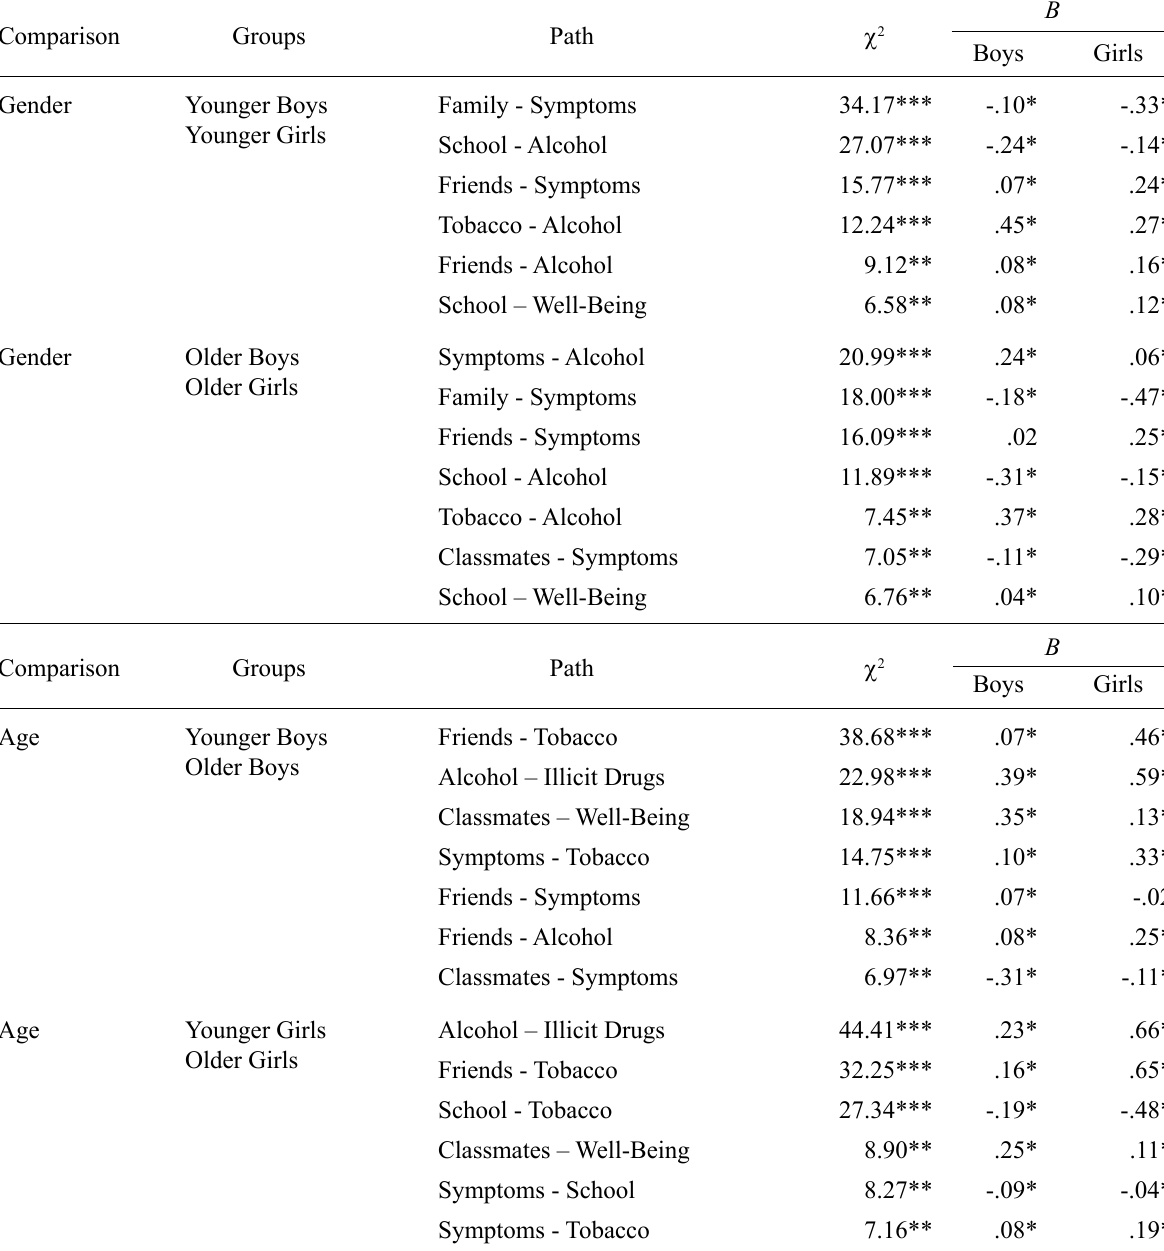
Table 4 Non-Invariant Paths in Gender and Age Group Comparisons Comparison